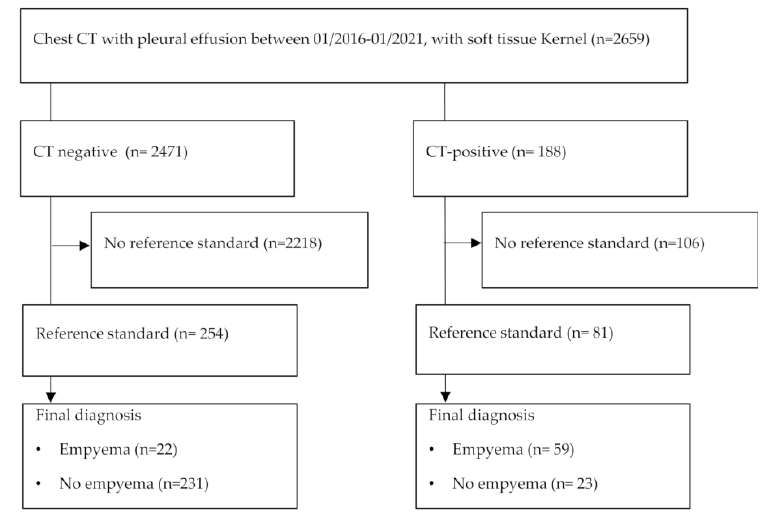
Figure 2. Study flow chart according to STARD [16].